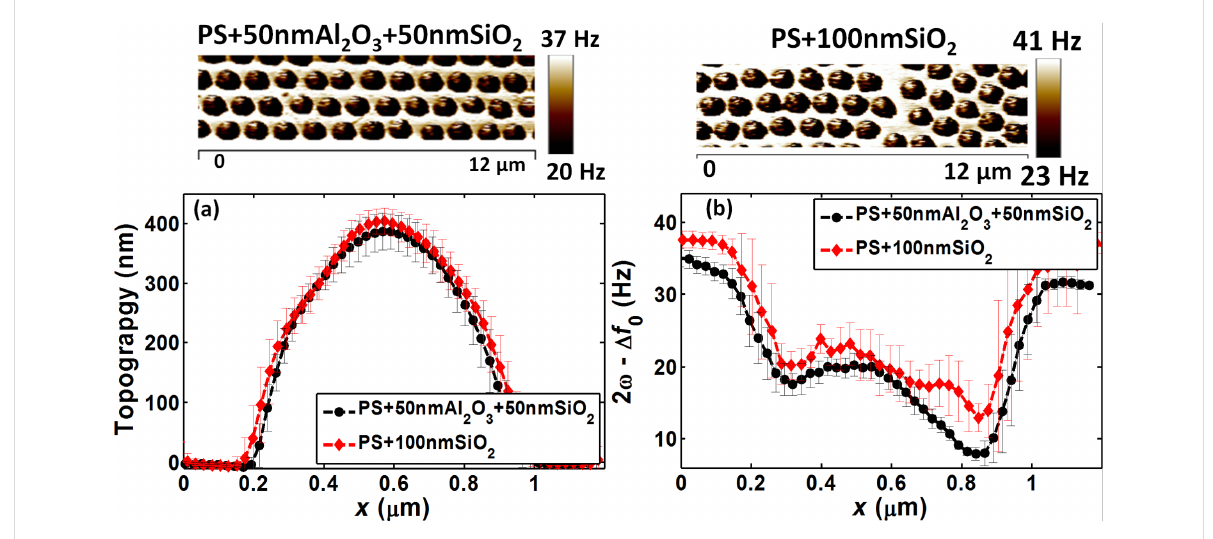
Figure 9: Approach 3 (step B) PS + 50 nm Al 2 O 3 + 50 nm SiO 2 and PS + 100 nm SiO 2 samples: (a) Average topography profiles, (b) average EFM signal profiles (lower panel) and the corresponding EFM images (upper panels). To avoid border effects, the EFM cross-sections were collected slightly far from the center and this is reflected by the change of the apparent particle width on the EFM average